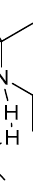
Figure 13. Equilibrium between monodeuterated 2,6-dihydroxyacylaromatics. X=H, CH 3 or OCH 3.